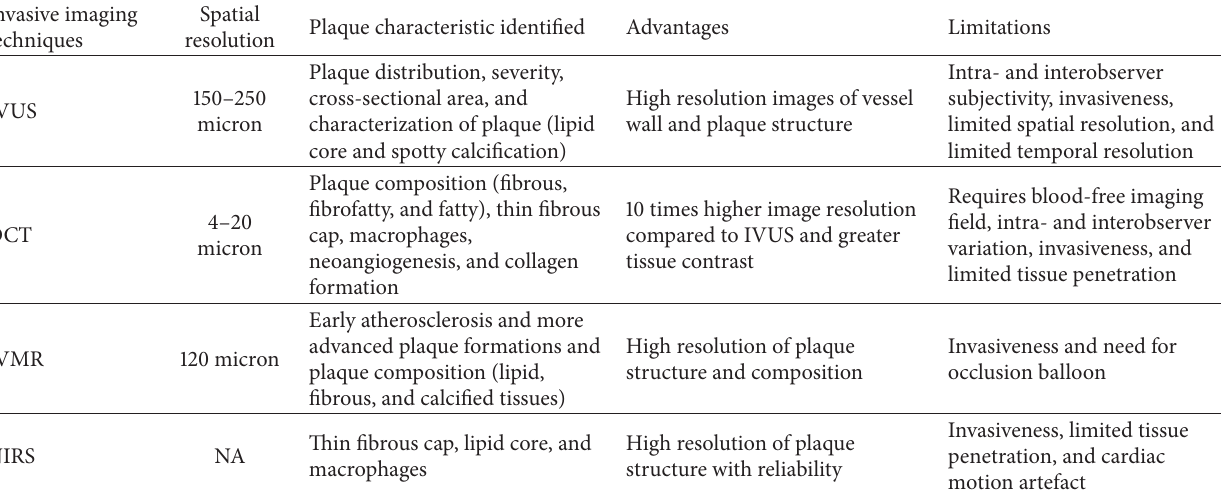
Table 2: Invasive imaging modalities to detect a vulnerable